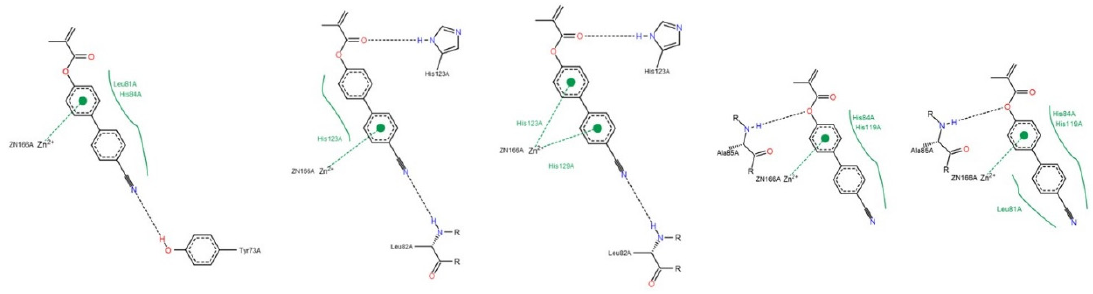
Figure A10. Interactions between compound A and MMP-13, by PoseView calculations.